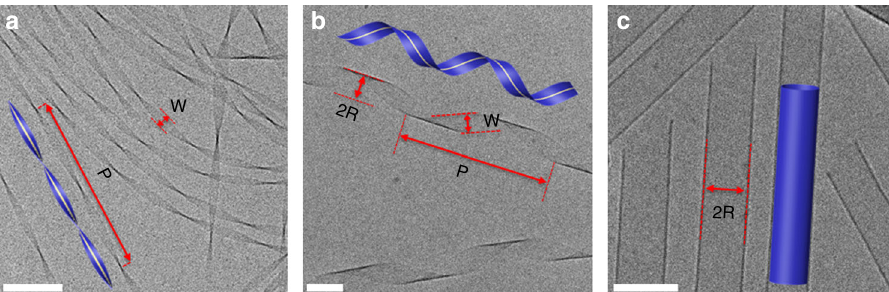
Fig. 1 Shape evolution and characterization: Cryo-TEM images and illustrations (insets) of self-assembled N- α -lauryl-lysyl-aminolauryl-lysyl-amide (C 12 - β 12 ) ribbons. a After ~24 h of assembly most ribbons are twisted, having a straight centerline, (inset, yellow dashed line) i.e. ribbons are abundant. Their center line is a helix with given pitch, P , and radius, R . Determination of W, P , and R from the image is demonstrated. c After 5 months most assemblies are tubes (distinguished by the dark parallel boundaries compared to the pale ends) with diameters D = 2 R ≈ 100 nm. Scale bars = 100